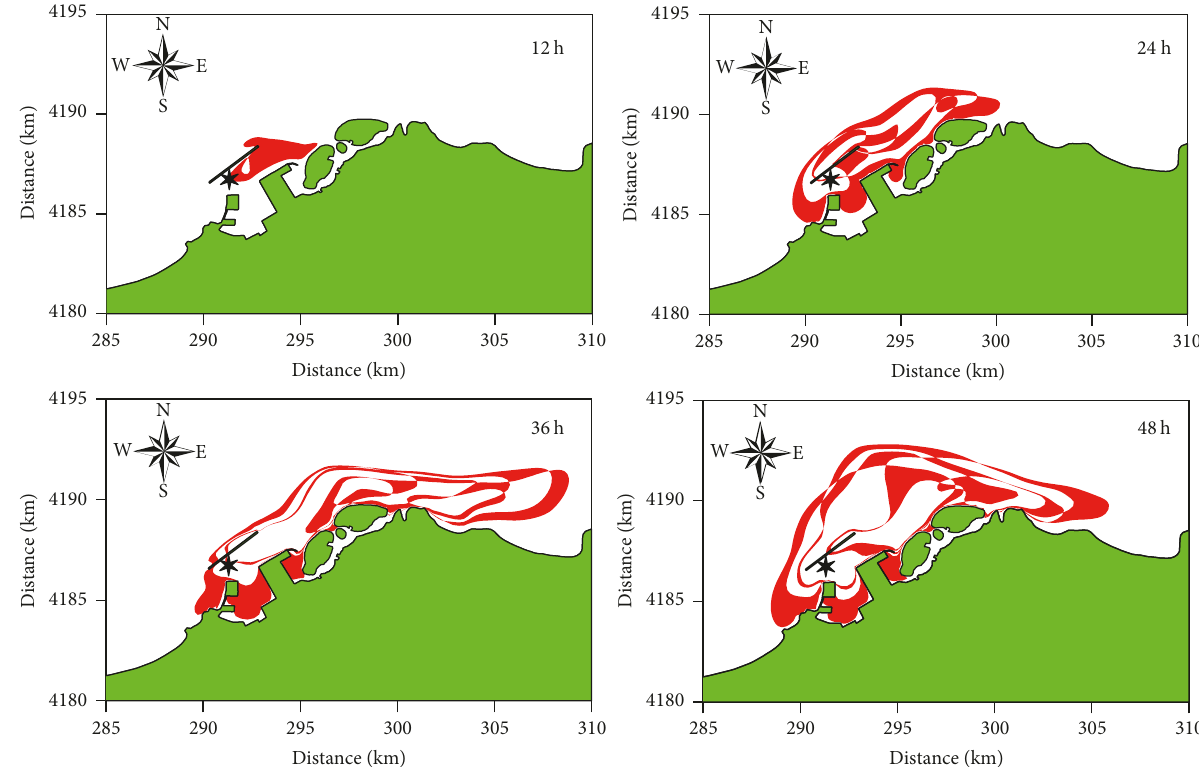
Figure 16: Transport processes of instantaneous oil spills (red area) from the western portion of the channel (black star symbol for the western spill location) in the case of no